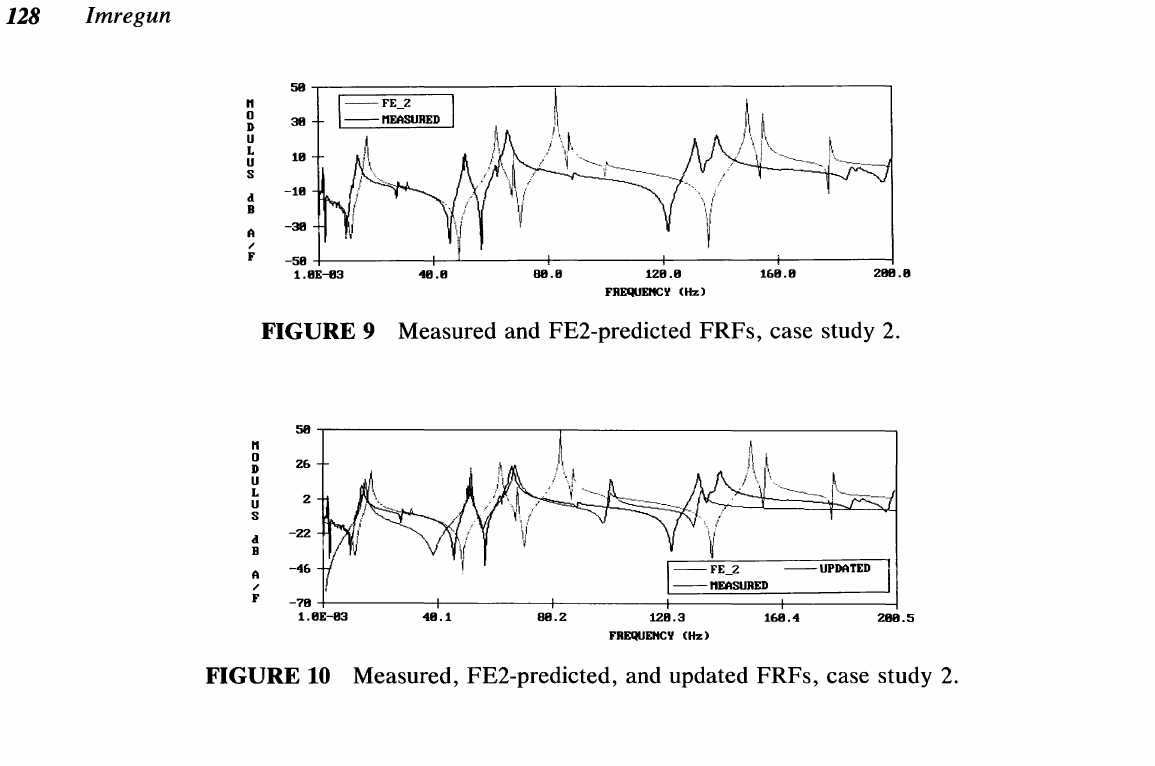
FIGURE 10 Measured, FE2-predicted, and updated FRFs, case study 2.